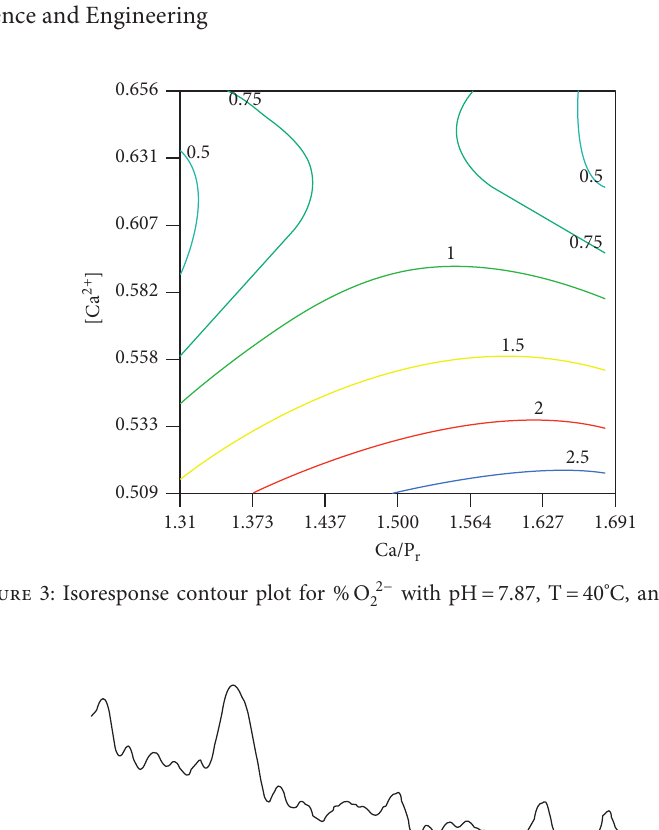
Figure 4: X-ray diffraction diagram of the obtained precipitate under optimum conditions.